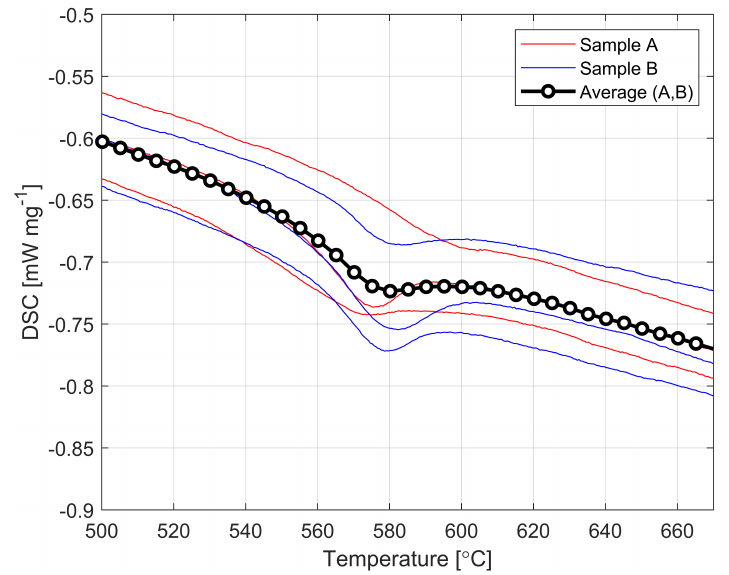
Figure 5. DSC graph in glass transition range.